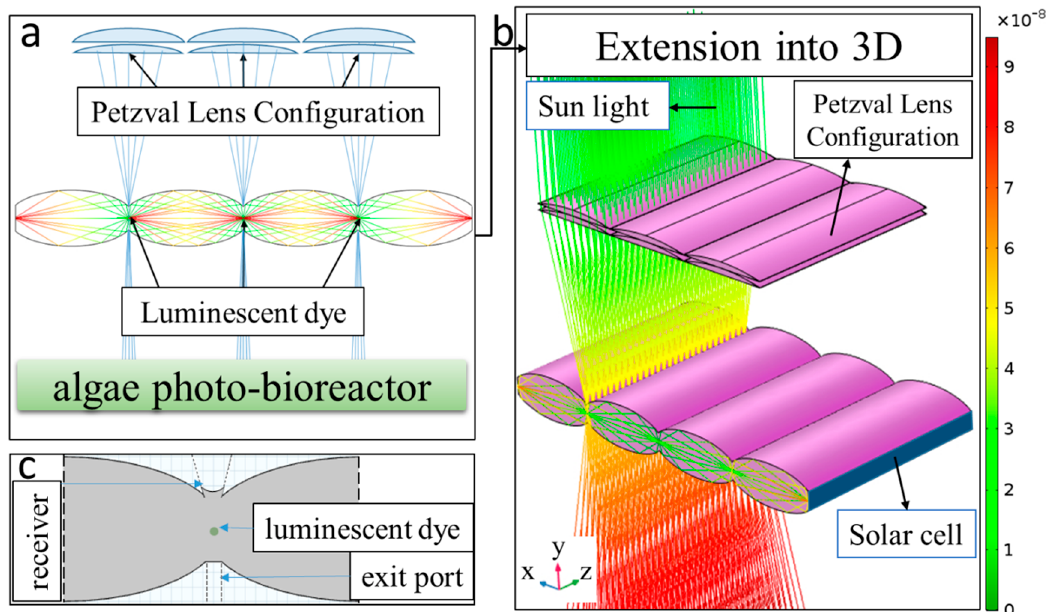
Figure 3. ( a ) The proposed configuration of Elliptic Array Solar Spectrum Splitter (EASSS) in 2D; ( b ) extension of the EASSS into 3D and; ( c ) The concept of receiver to couple the incoming concentrated light from Petzvel lens to the luminescent dye area and send out through the exit port.